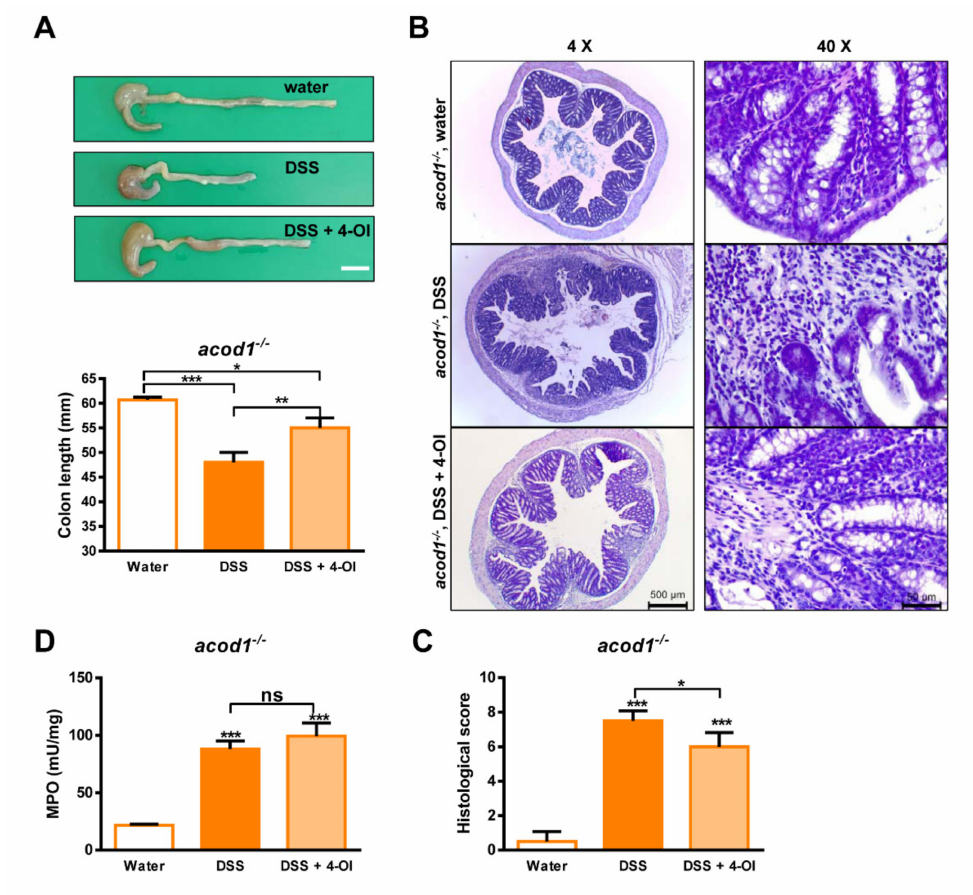
Figure 5. The effects of 4-octyl itaconate (4-OI) on the clinical features of acod1 − / − mice with DSS- induced colitis. ( A ) Morphological changes in the colons of acod1 − / − mice with DSS-induced colitis treated with or without 4-OI. The colon lengths in each group were measured on Day 7 (n = 6–8). Representative histological images of colon sections ( B ) and histological scores ( C ) of acod1 − / − mice with DSS-induced colitis treated with or without 4-OI. Left panel images taken using 4 × objective on an H&E-stained tissue section (Scale bar: 500 um). Right panel images taken using 40 × objective on an H&E-stained tissue section (Scale bar: 50 um). ( D ) Myeloperoxidase activity was measured to quantify neutrophil infiltration in the colon. Symbols *, **, and *** denote p < 0.05, p < 0.01, and p < 0.001,